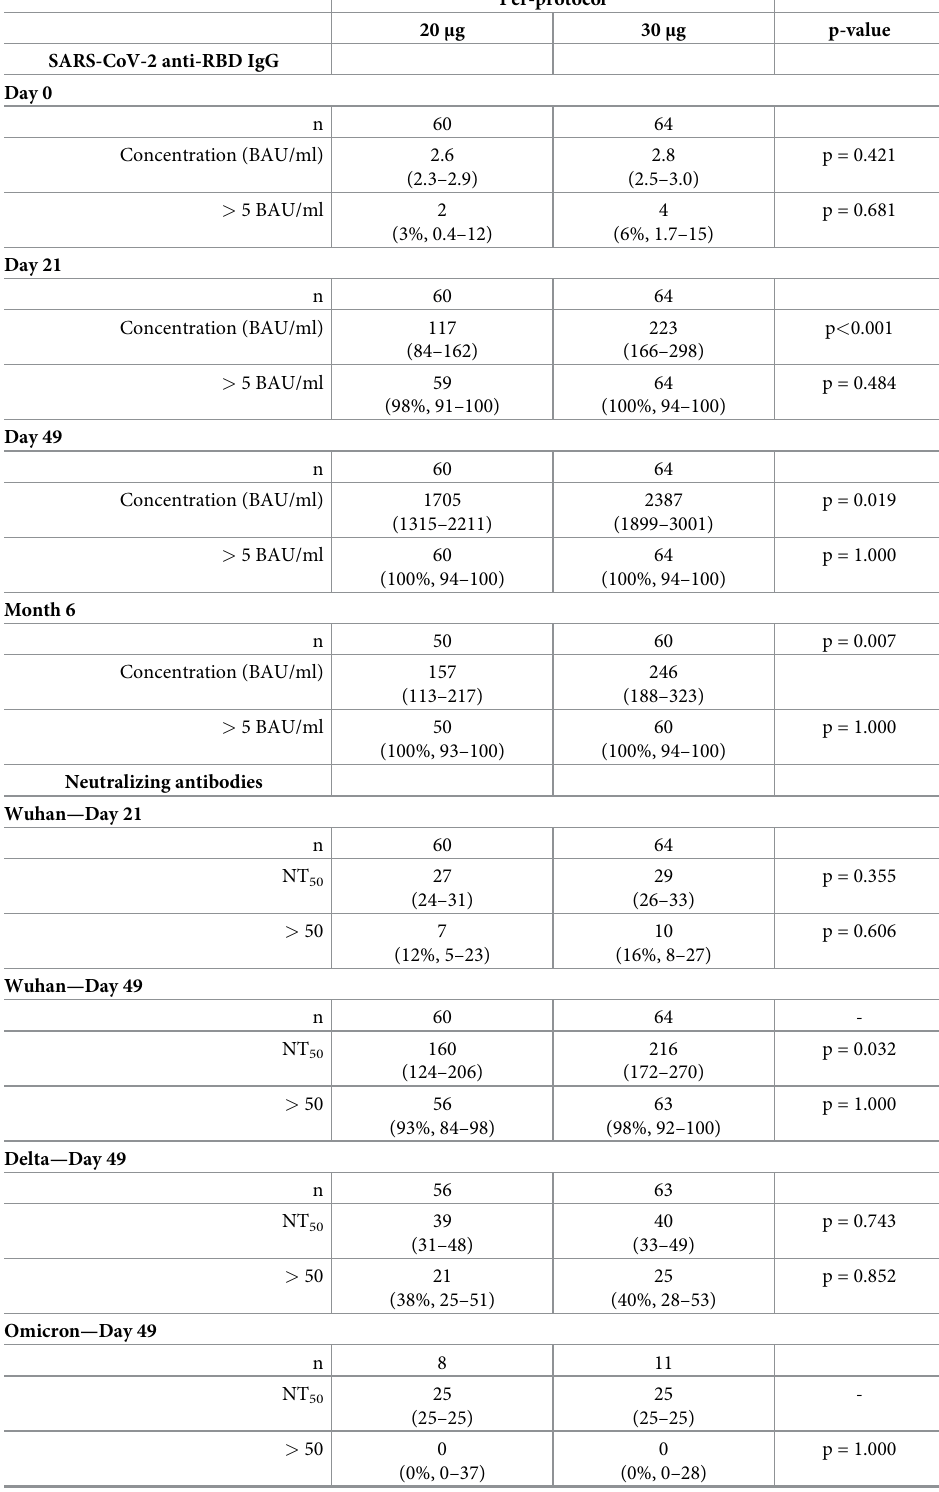
Table 2. Humoral and cellular responses by study arm in the per-protocol cohort at the different time